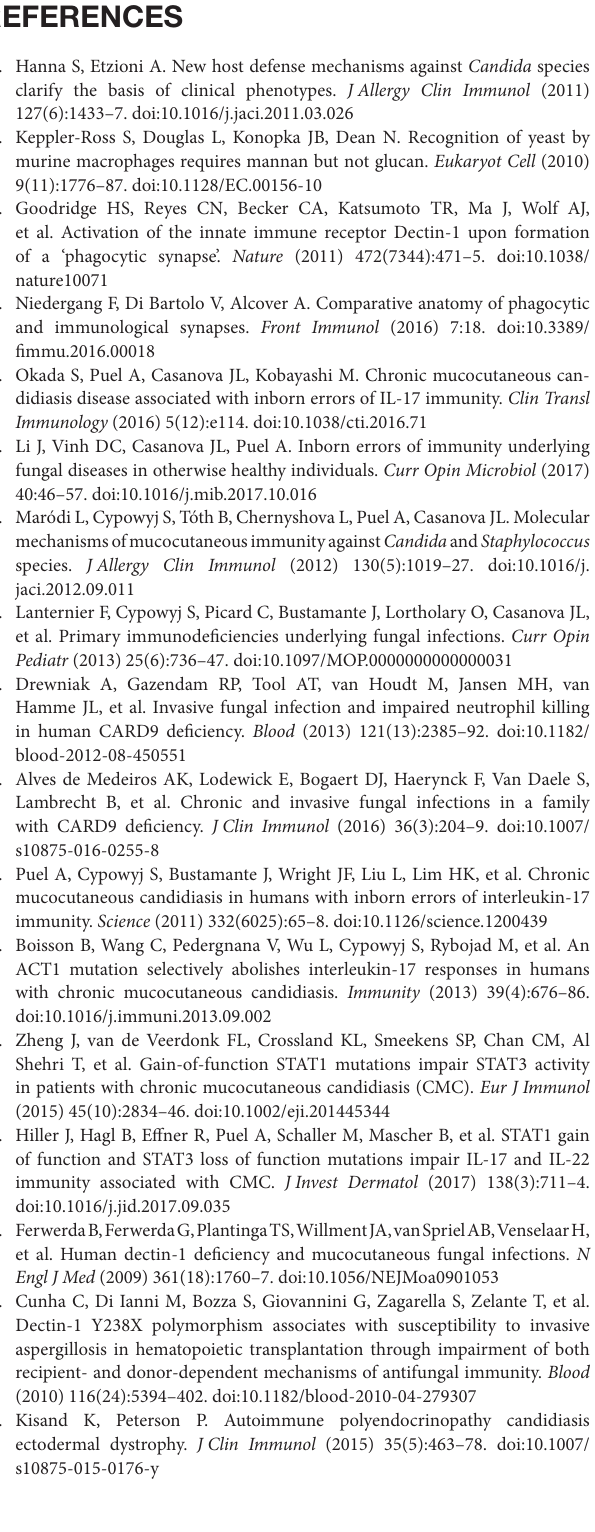
FigUre s7 | Cytokine secretion and E. coli phagocytosis in healthy donor or APECED patient macrophages stimulated with LPS. (a) Healthy donor or AIRE-deficient patient macrophages stimulated with E. coli for 30 min, lysed and cultured in LB agar. CFU was counted after overnight incubation at 37°C.